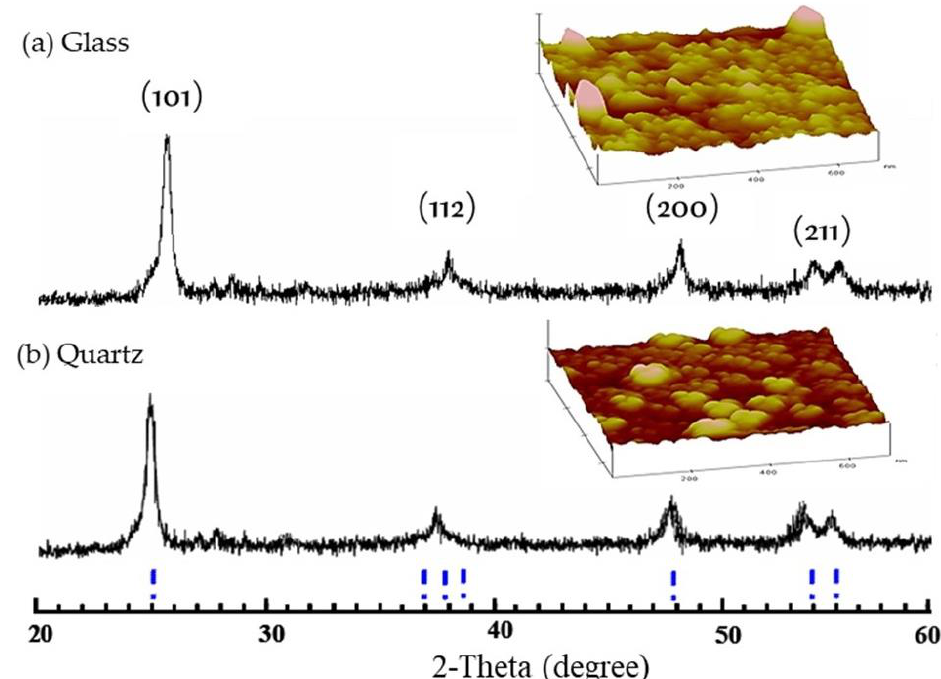
Figure 1. XRD patterns and AFM contact mode topographic images of TiO 2 film mounted on ( a ) glass, and ( b ) quartz substrates.